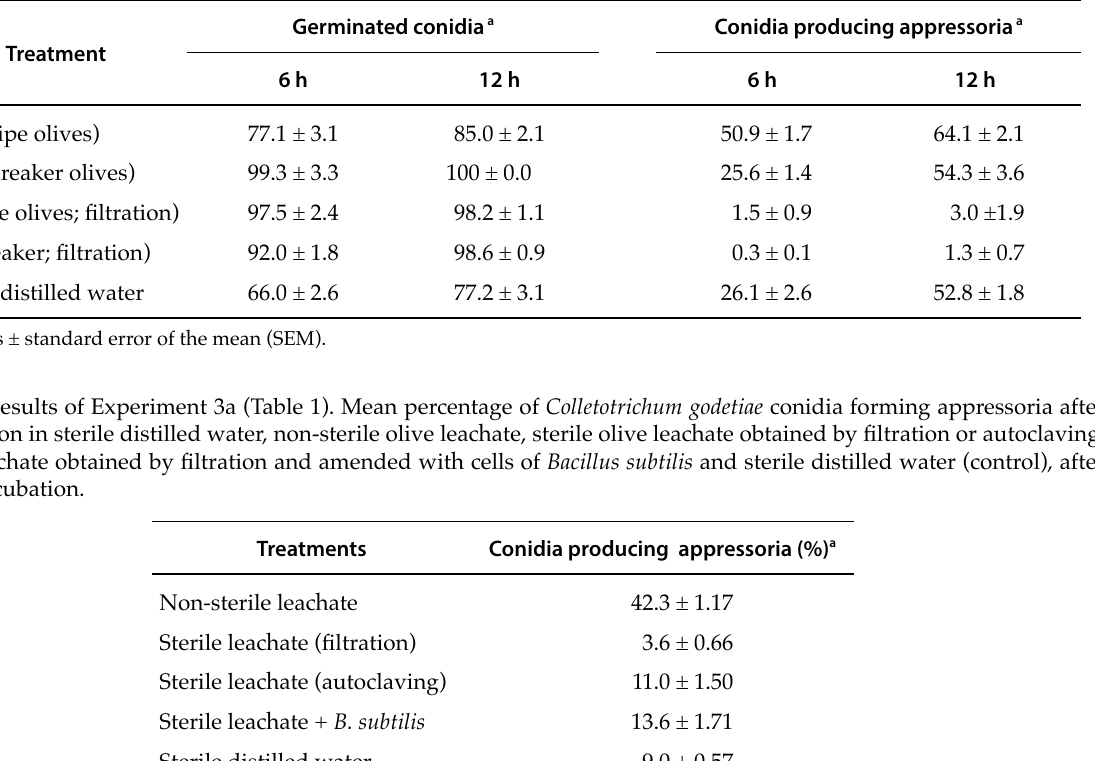
Table 5. Results of Experiments 2a and b (Table 1). Mean percentage of germinated Colletotricum godetiae conidia and of conidia producing appressoria after 6 and 12 h incubation in sterile (SL) and non-sterile (NSL) olive leachates from ripe and breaker olives, or in sterile distilled water (control).